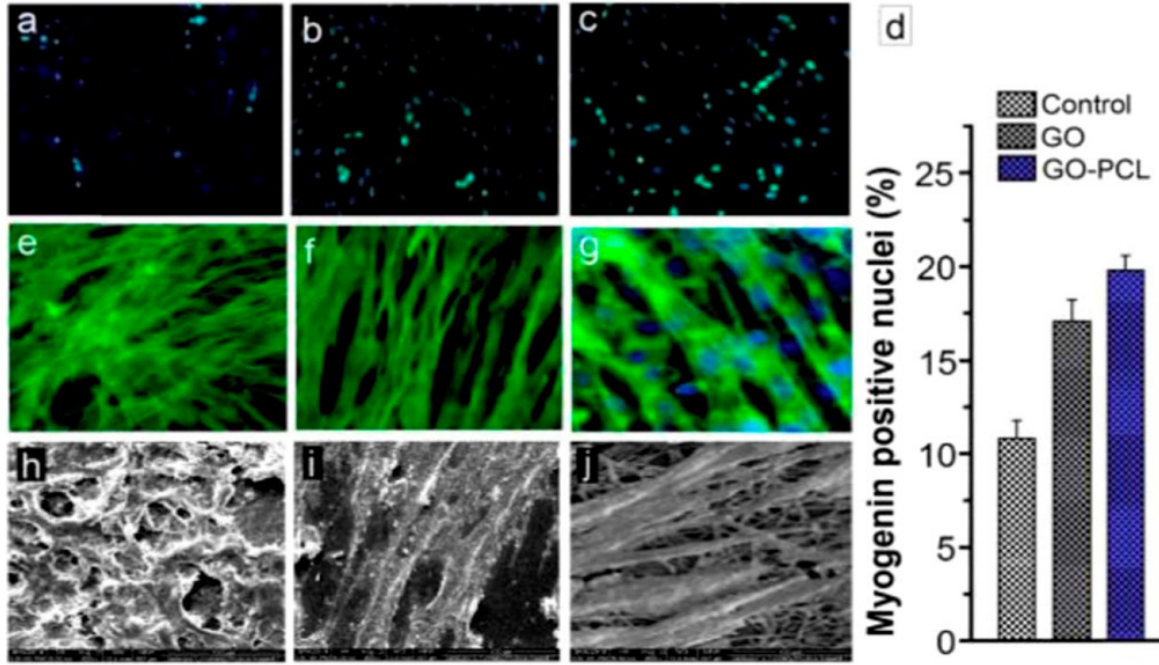
Figure 8. Myogenin on tissue culture plate stained using immunofluorescence taken as control ( a ), GO sheet ( b ), and GOPCL electrospun fibers ( c ) including their quantitative analysis of the myogenin-positive nuclei ( d ). Immunofluorescence staining of myosin heavy chain (MHC) ( e – g ) and the FESEM micrographs ( h – j ) of the related samples [204]. Reproduced with permission from Ref. [210]. Copyright 2021 the American Chemical Society.